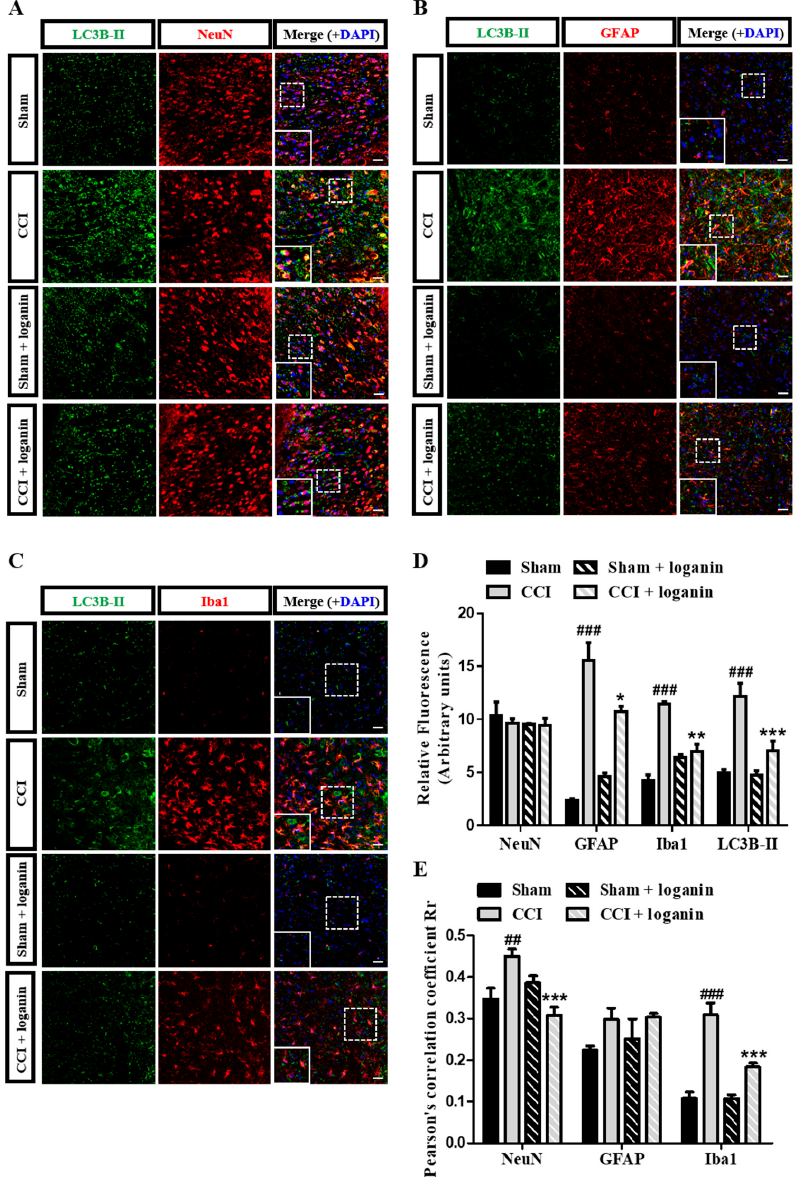
Figure 2. Double immunofluorescent staining for LC3B-II (autophagosome marker) and NeuN (neuronal marker), GFAP (astrocyte marker), and Iba1 (microglia marker) in the spinal cord on day 7 after chronic constriction injury (CCI). Representative images of IHC staining for LC3B-II (green) and ( A ) neuronal marker NeuN (red), ( B ) astrocyte marker GFAP (red), and ( C ) microglia marker Iba1 (red) in the spinal cord. The region of interest’s fluorescence (dash box) is amplified at the bottom box. The scale bar is 50 μ m. ( D ) Quantification of NeuN, GFAP, Iba1, and LC3B-II signals in ( A – C ). ( E ) Pearson’s correlation coefficients quantified the degree of colocalization between LC3B-II and each neuron marker from ( A – C ). Sham-operated rats were the subjects of the same procedure without nerve manipulation. These data represent the mean ± SE for 6 rats per group. ## p < 0.01, ### p < 0.001 compared with sham group at the corresponding time points; * p < 0.05, ** p < 0.01, *** p < 0.001 compared with CCI group.